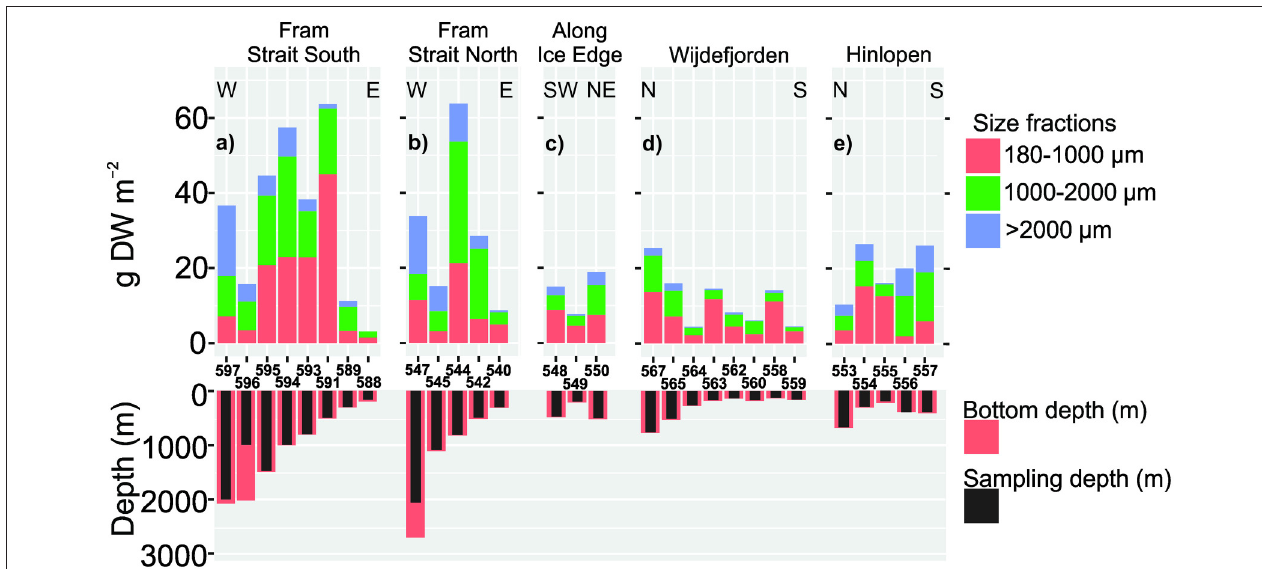
FIGURE 8 | Upper: Regional size-fractionated mesozooplankton biomass in g DW m − 2 from a vertically operated WP2 net (180 µ m mesh size). Lower: Bottom and sampling depths along transects. Station numbers between panels. W, E, N, S, SW, NE represent West, East, North, South, South-West and North-East respectively. (a) Fram Strait South (T6), (b) Fram Strait North (T2), (c) Along Ice Edge (T3), (d) Wijdefjorden (T5), and (e) Hinlopen (T4).